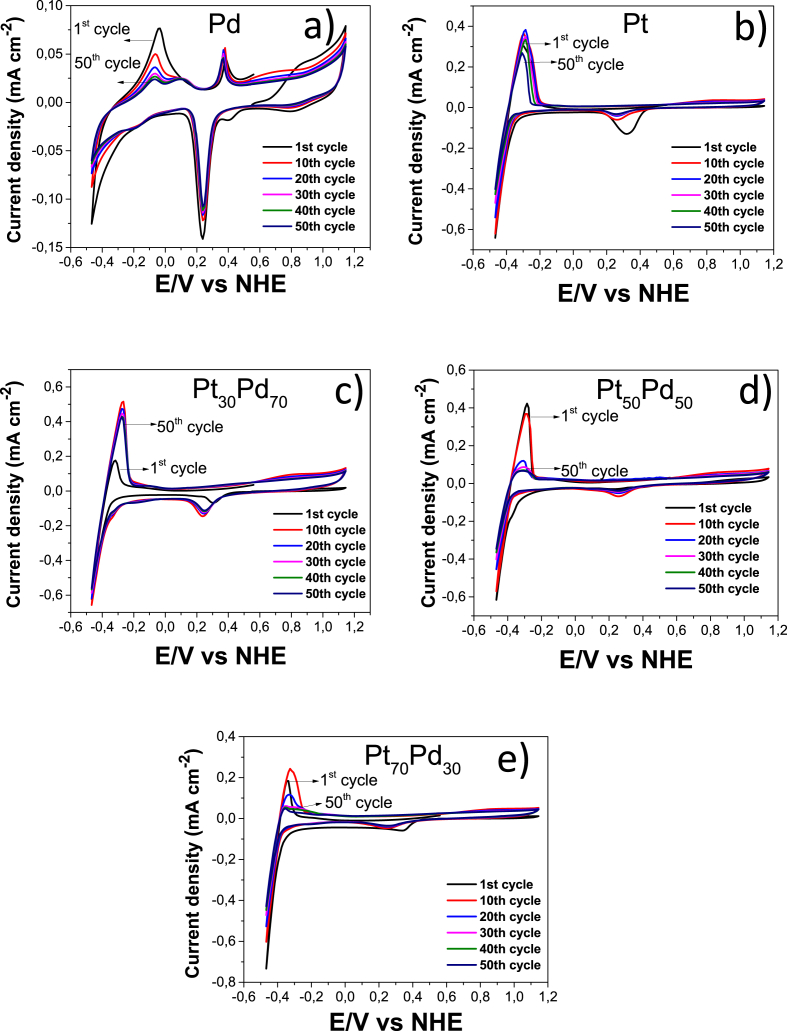
Cyclic voltammograms of a) Pd, b) Pt, c) Pt30Pd70, d) Pt50Pd50 and e) Pt70Pd30, evaluated in 1 M KOH at 25 °C using a scan rate of 10 mV s−1.